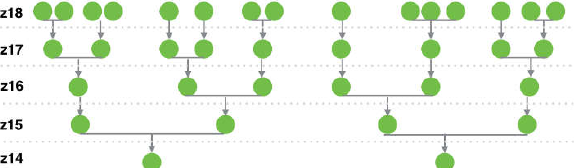
Figure 1 . Hierarchical greedy clustering using in Google Maps and Mapbox (Agafonkin,